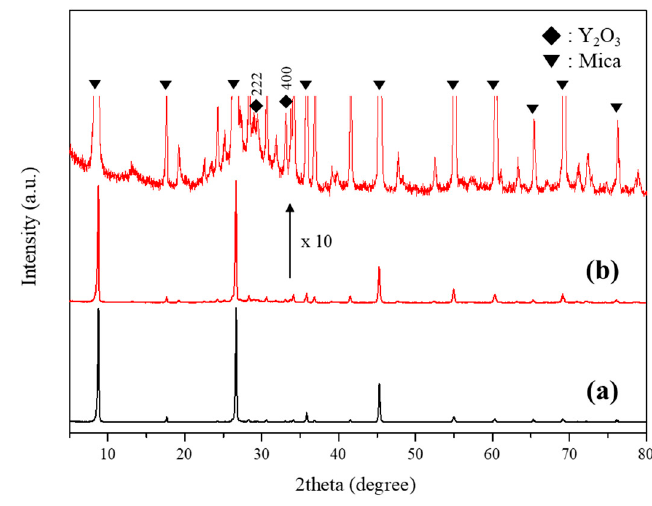
Figure 5. Powder XRD patterns of ( a ) mica flake and ( b ) Y 2 O 3 :Eu@MF (10 wt%).